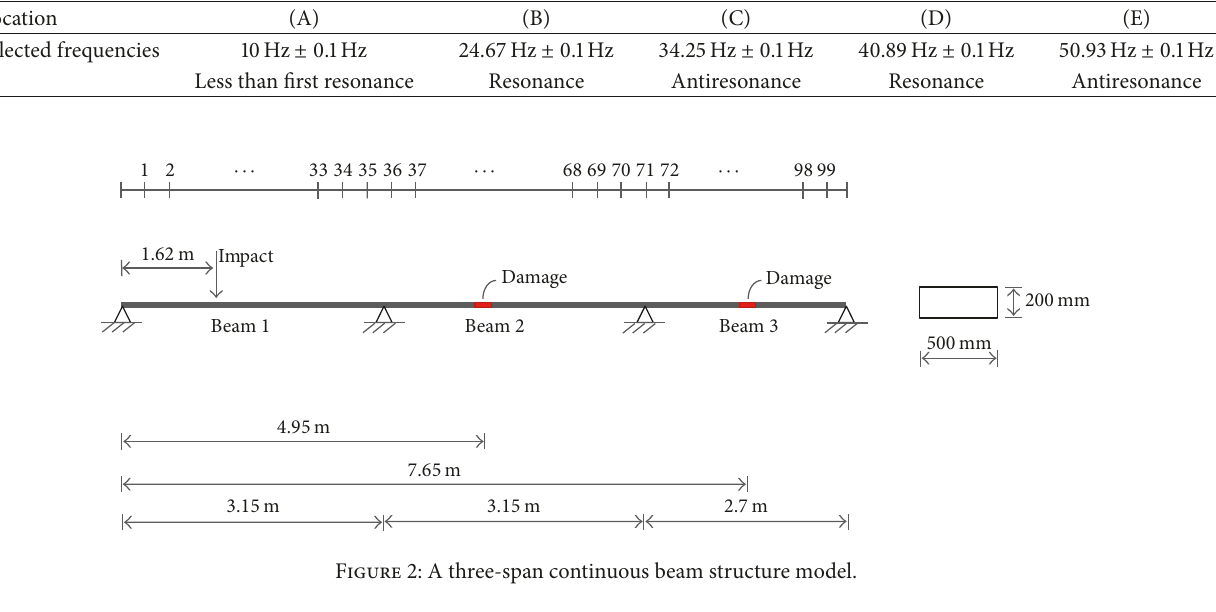
Table 1: Frequency ranges of the extracted FRFs.